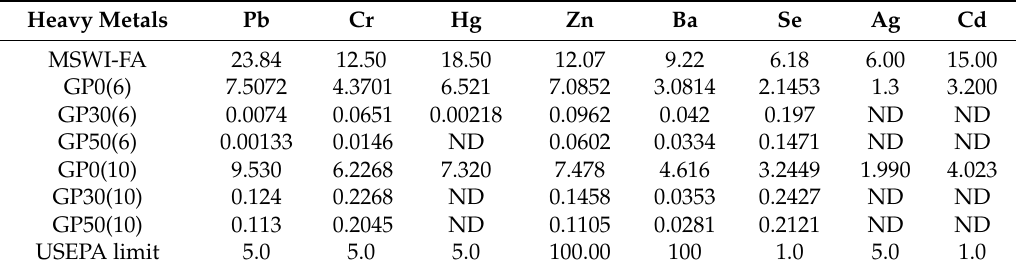
Table 4. Leaching concentration (mg · L − 1 ) of MSWI-FA, VA, MSWI-VA based Geopolymer, landfill limit, and percentage of leach